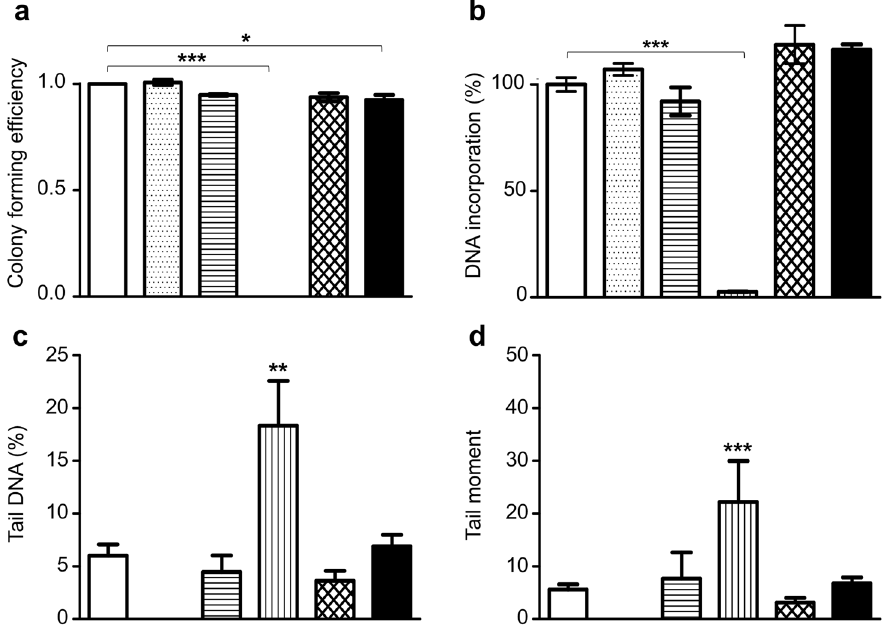
Figure 4. Effect of modified gold nanoparticles (AuNPs) on cell division and proliferation. ( a ) The Colony forming efficiency assay was performed on cell treated with modified AuNPs (10 μ g/ml). MUAM-AuNPs treated cells did not form colonies over 50 cells. The number of colonies also decreased slightly in CP2-AuNP treated cells. ( b ) The effect of modified AuNPs on DNA replication was analysed. MUAM-AuNPs inhibited DNA replication near to completion. (c and d) AuNPs-induced DNA damage was monitored using the Comet Assay. Measurements of % tail DNA ( c ) and tail moment ( d ) suggest severe DNA damage in MUAM-AuNPs treated samples ( * p < 0.05 , ** p < 0.01 , *** p < 0.001 , one-way